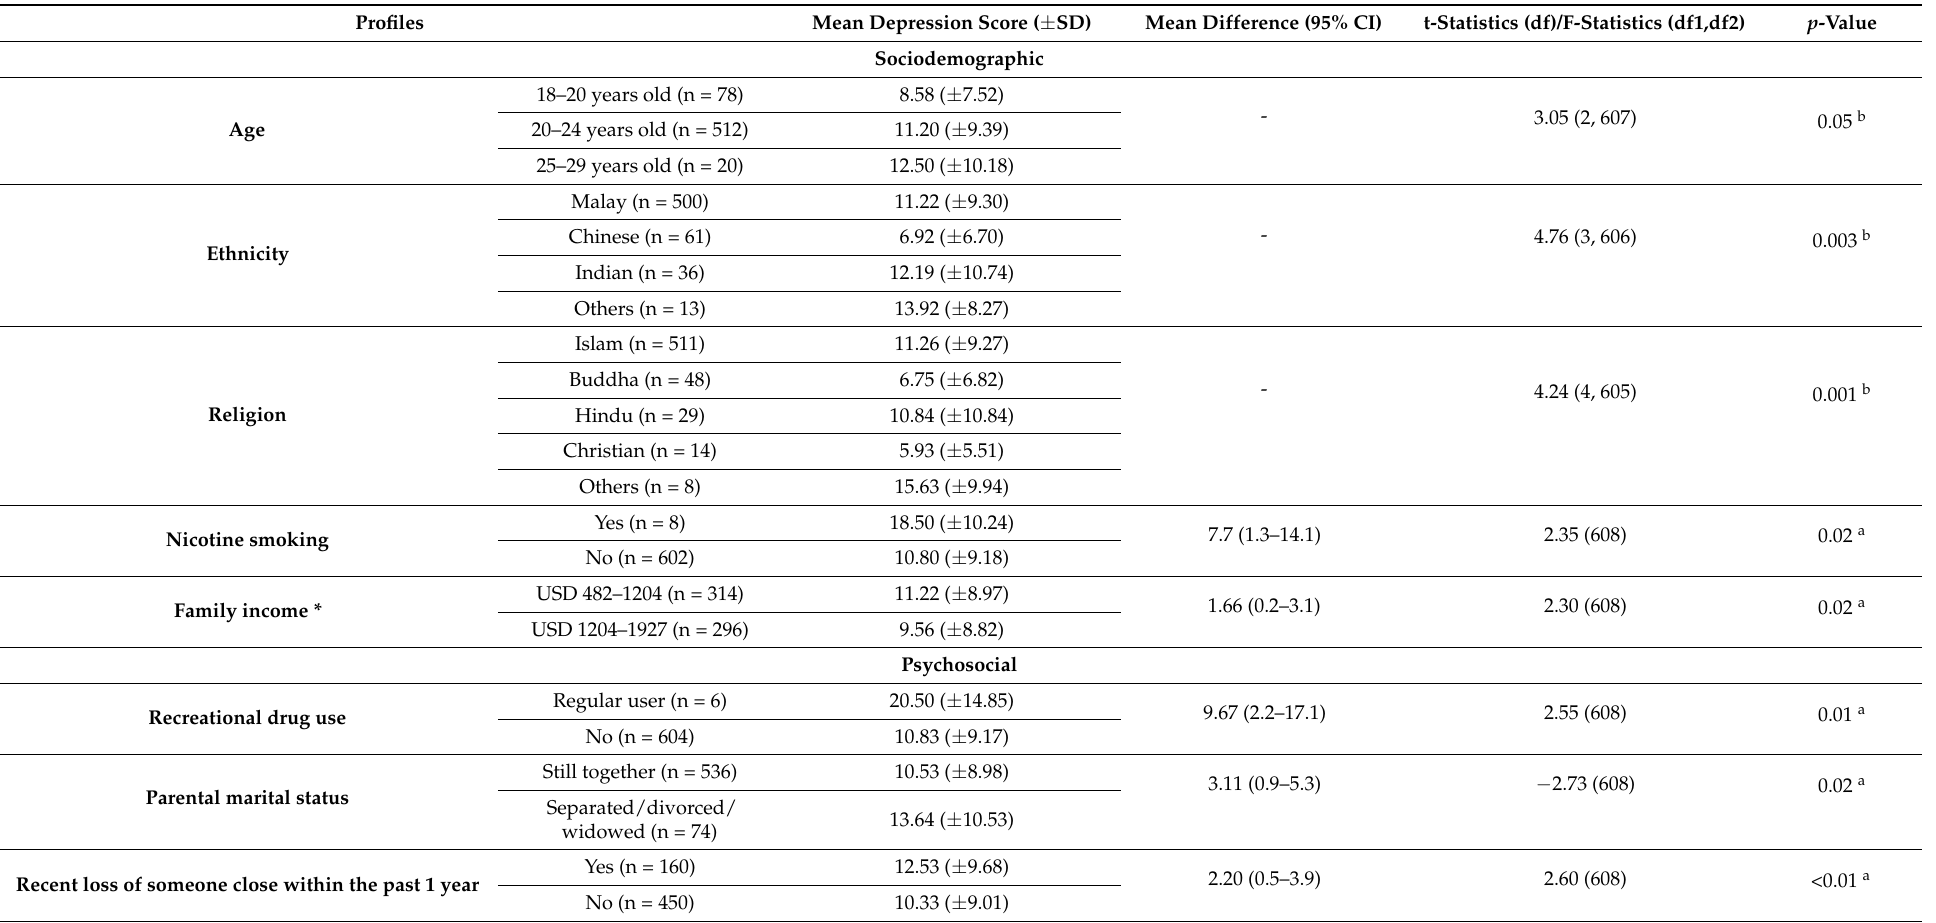
Table 3. Significant difference in mean depression score of DASS-42 between groups (n =